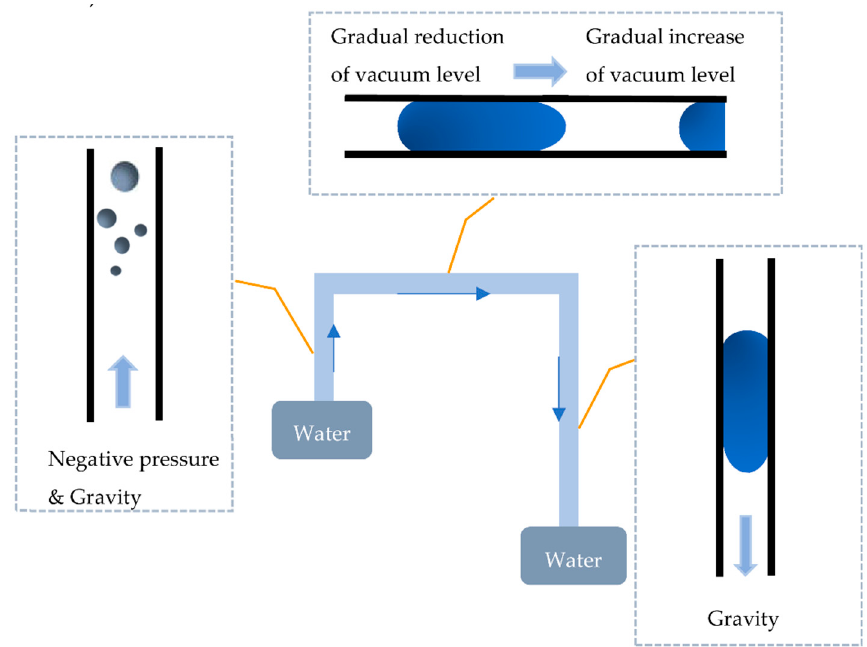
Figure 3. Diagram of the test device.